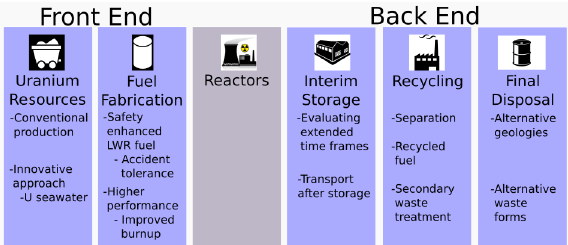
Figure 1. ATF shall not negatively (economically or technically) impact fuel cycle technologies. For that reason, integrated evaluation approach has to be adopted.